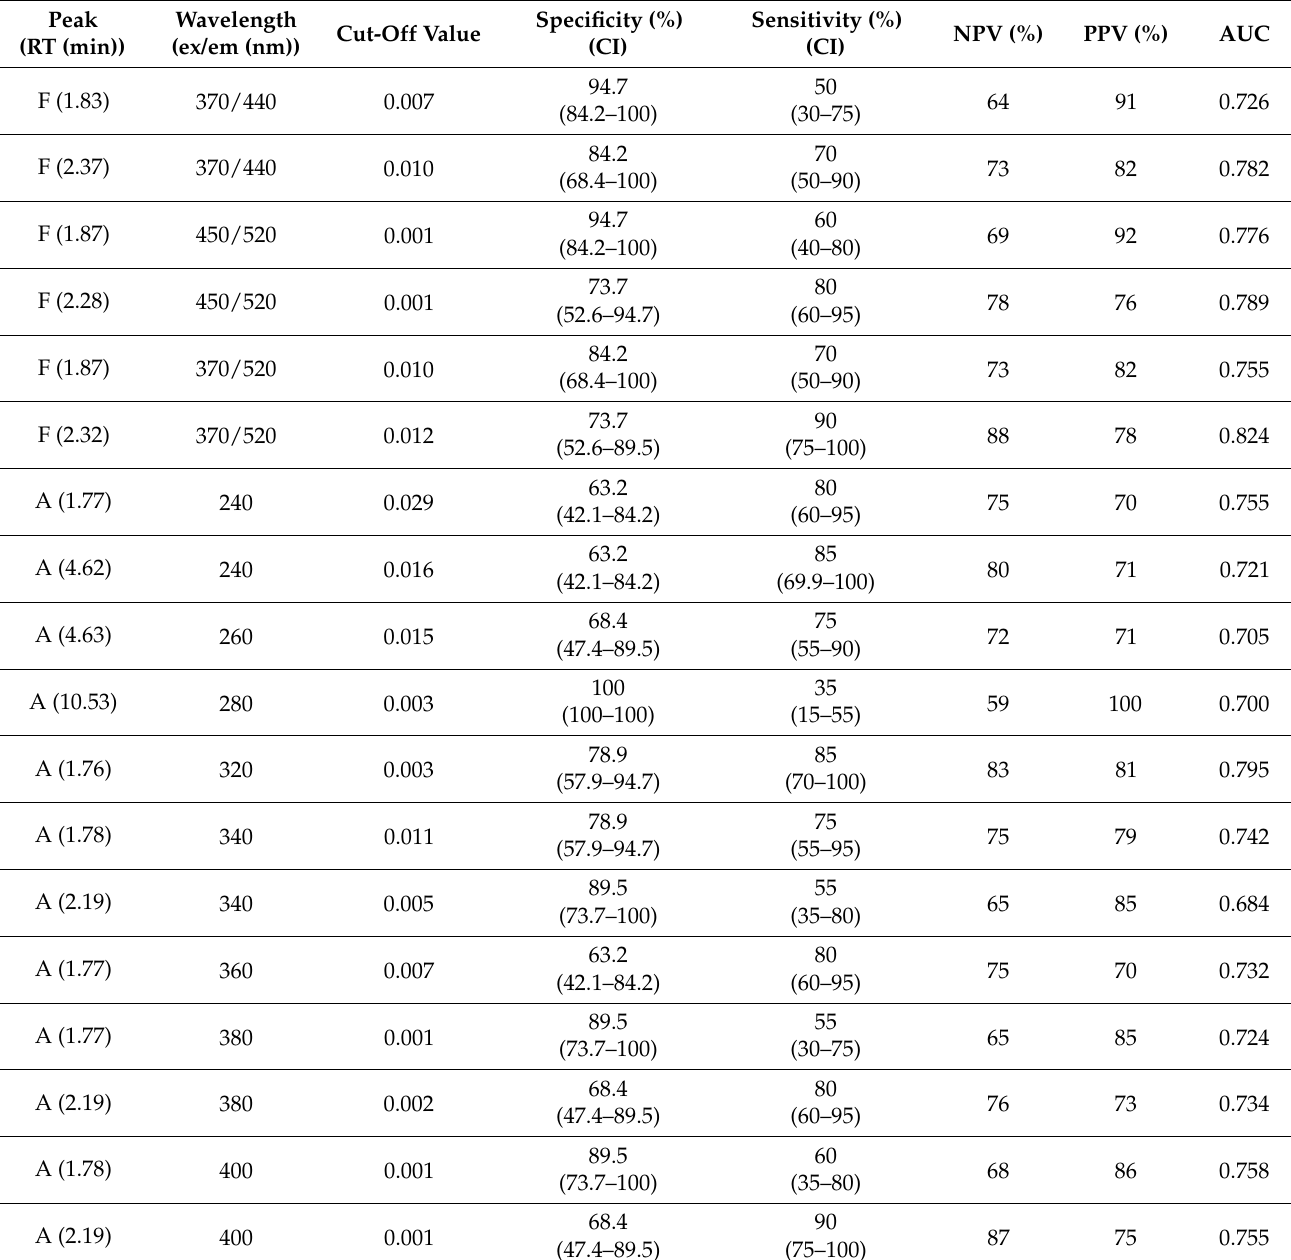
Table 5. Summary of ROC curve analysis of 18 significant